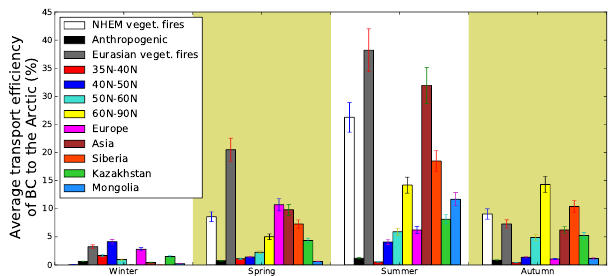
Figure 10. Relative transport efficiency of BC from vegetation fires from different geographic regions across the Arctic. The same colours were used as in Fig.